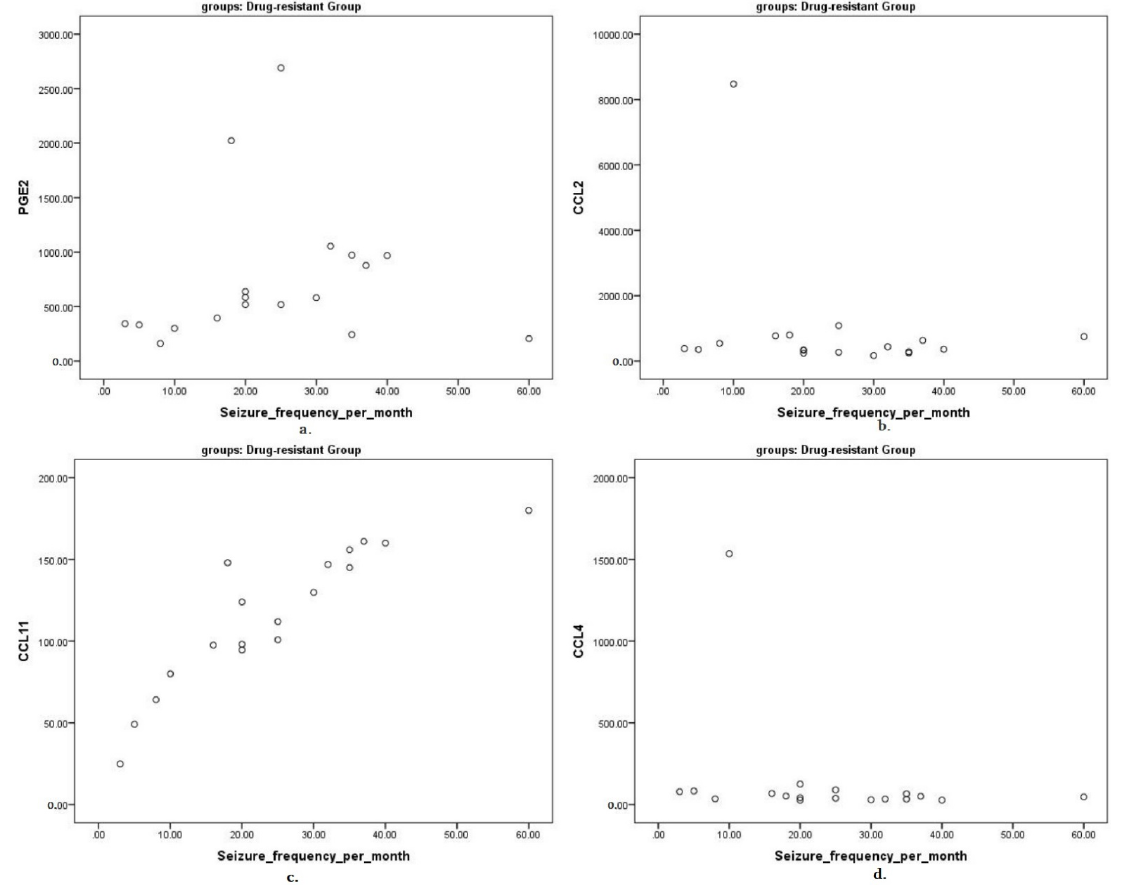
Figure 2. Correlation of targeted proinflammatory cytokines in pg/mL and seizure frequency per month presented as scatterplots: ( a ) PGE2 and seizure frequency; ( b ) CCL2 and seizure frequency; ( c ) CCL11 and seizure frequency; ( d ) CCL4 and seizure